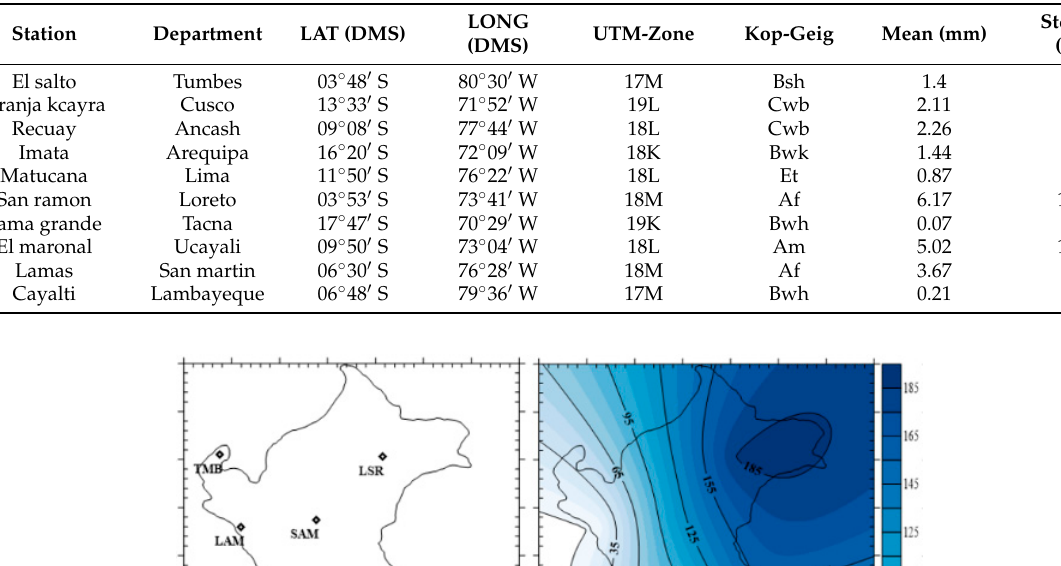
Table 1. Information of the meteorological stations and statistical characteristics of measured precipi- tation (from 1990 to October).